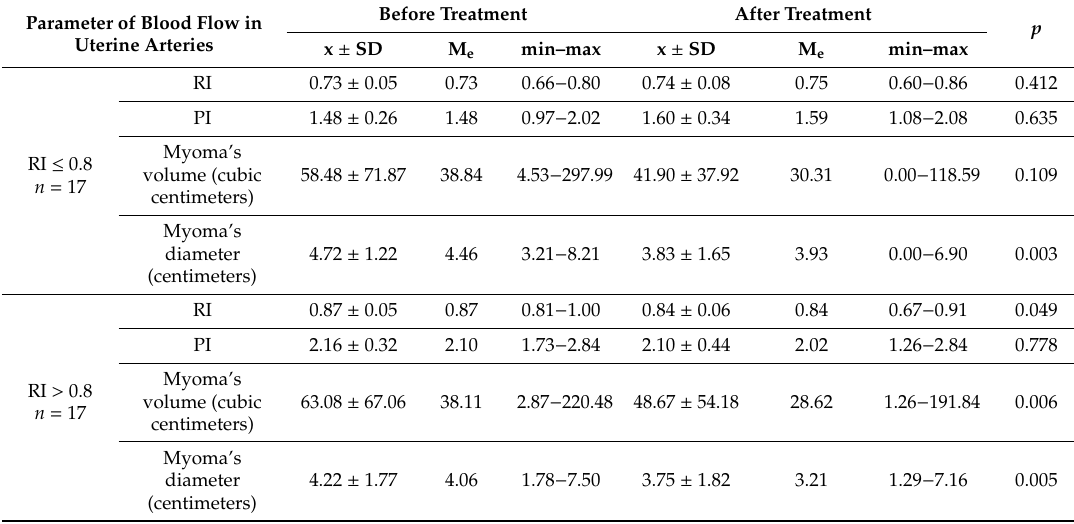
Table 6. The mean values of the pulsatility index (PI) and resistance index (RI) of uterine arteries before and after 3 months of treatment with ulipristal acetate depending on the initial parameters of blood flow in uterine arteries. RI and PI indexes were calculated as the mean of both sides: from left and right uterine